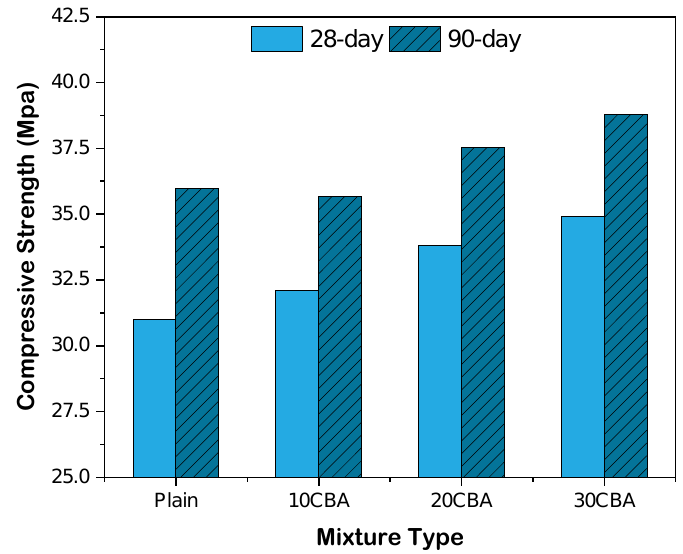
Figure 6. Compressive strength of concrete mixed with CBA. The maximum strength of 34.9 MPa and 38.78 MPa after 28- and 90-day water curing, respectively, was achieved at 30% replacement of sand with CBA, while the minimum strength of 32.1 MPa and 35.67 MPa was achieved after 28 and 90-day water curing, re-